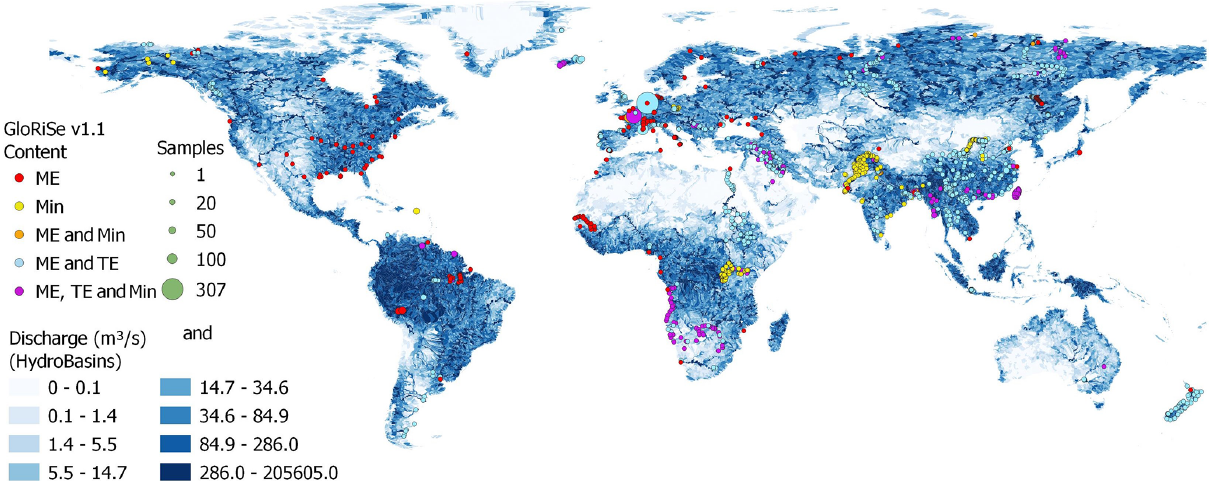
Figure 1. Spatial extent of the database. Dot size indicates the number of samples available per location. Dot colour indicates what kind of data are available at that location (ME: major and minor elements, TE: trace elements, Min: mineralogical or petrological composition). River water discharge, as indicated by blue colouration, was taken from the HydroBASINS database at Pfaffstetter level 7 (Linke et al.,